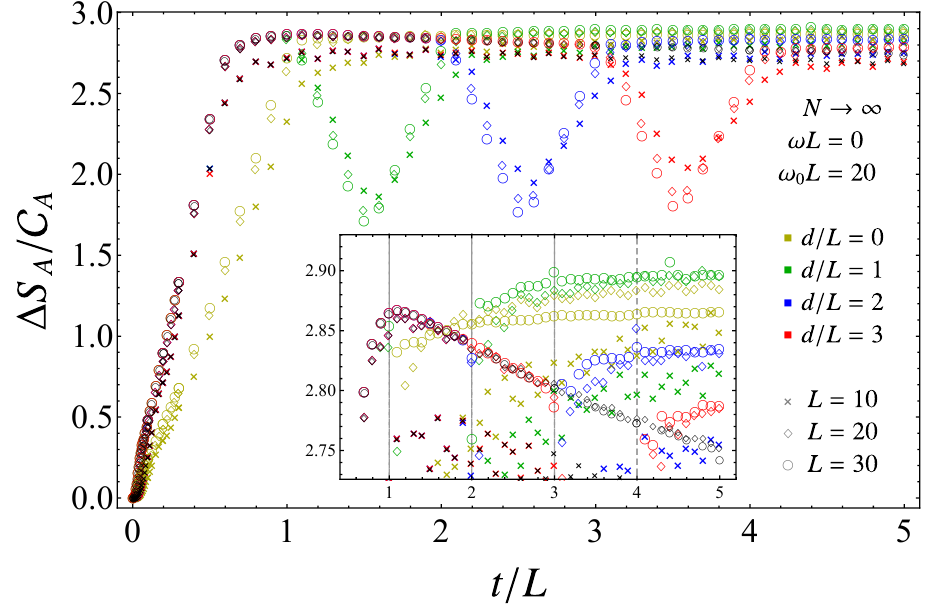
Figure 15 . Temporal evolution of ∆ S A / C A for the data reported in figure 14. The inset zooms in to highlight the data points having t/L > 1